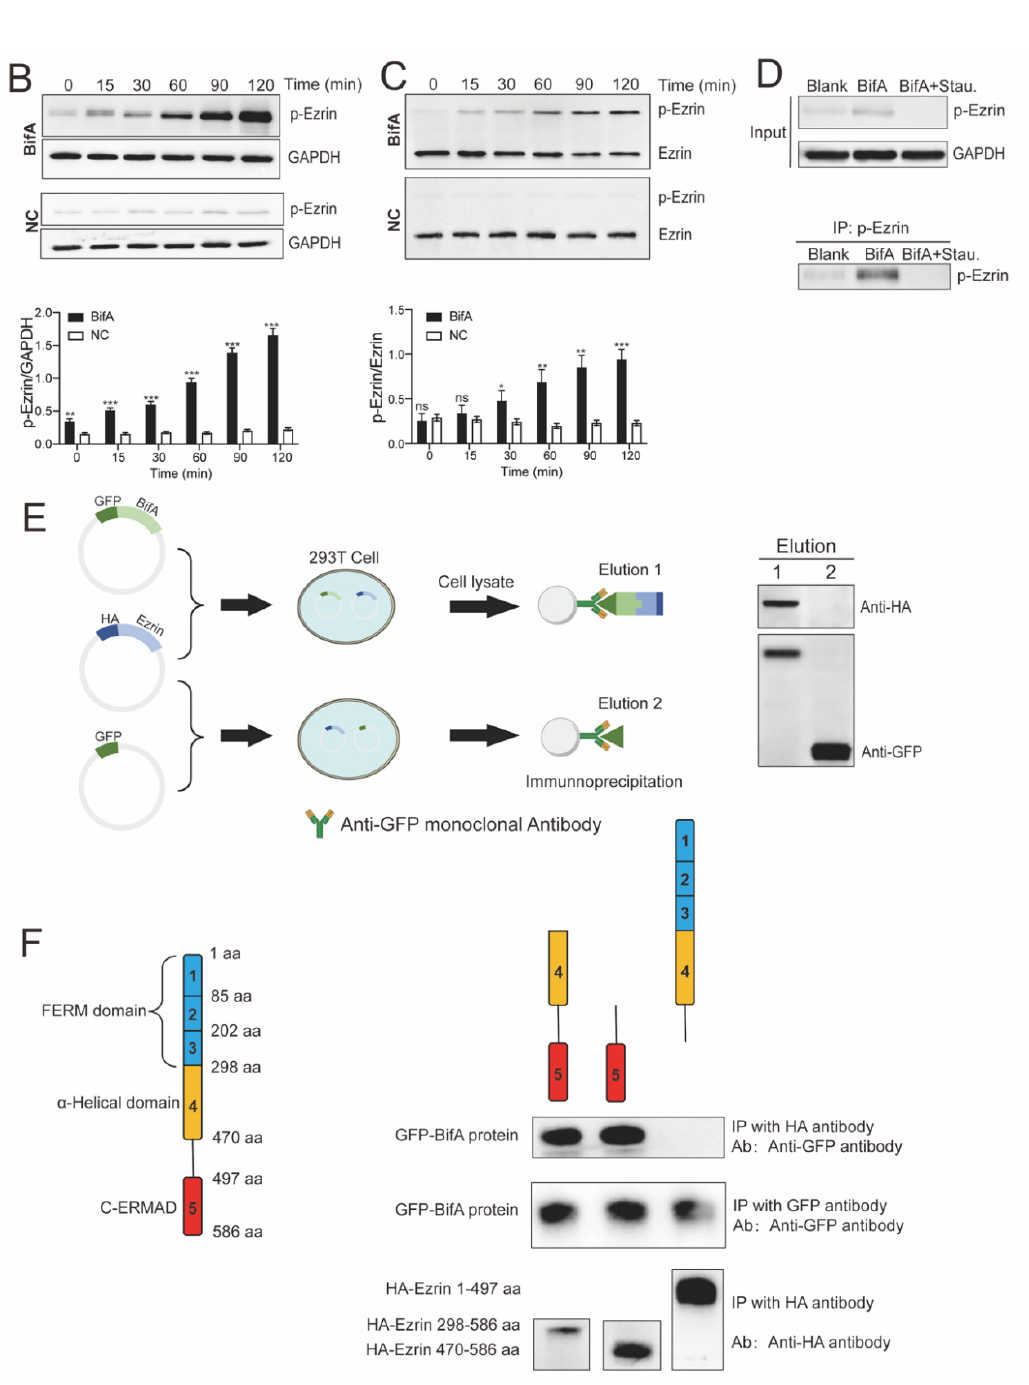
Figure 2. The bifA gene defective SEZ strain is more susceptible to neutrophils killing. BifA interacts with ezrin and elevates p-ezrin levels in dHL60 cells. ( A ) Observation of dHL60 cells incubated with BifA or Negative Control (NC) by immunofluorescence microscopy. BifA and p-ezrin were detected by immunostaining with an anti-BifA polyclonal antibody (green) and an anti-p-ezrin antibody (red), respectively, and DAPI was used as a counterstain for nuclei (blue). (Bar = 20 µ m) The yellow lines in the merged pictures were in accordance with the line length ( X -axis) of graphs on the right. The Y -axis showed the signal intensity of the three colors channels along with the yellow line. The overlap of green and red curves indicated the colocalization of BifA and p-ezrin in merged pictures. ( B ) Immunoblot detection of ezrin phosphorylation in dHL60 cells under BifA or NC treatment at different time points with anti-p-ezrin antibody. The gray intensity was measured with Image